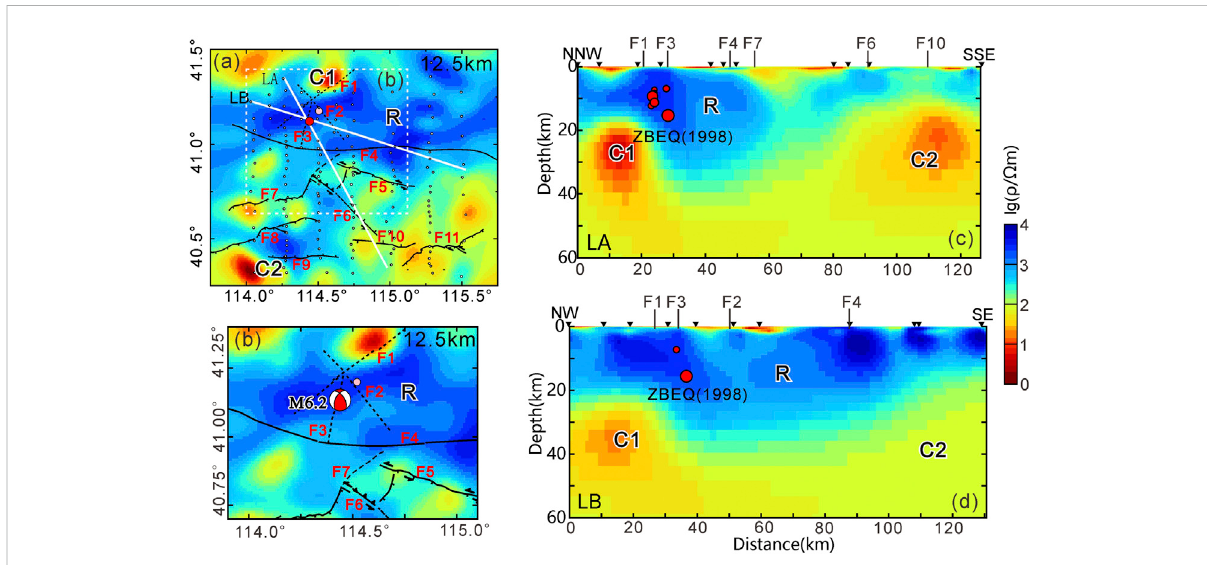
FIGURE 10 Electrical structure beneath the Zhangbei earthquake. (A) Map view of the 3D inversion model in the Western section of ZBFZ at depth of 12.5 km; (B) Mapview ofthe3DinversionmodelneartheZhangbei earthquake atdepthof12.5 km; (C) and (D) Crosssectionsof3Dinversionmodel along pro fi les LA and